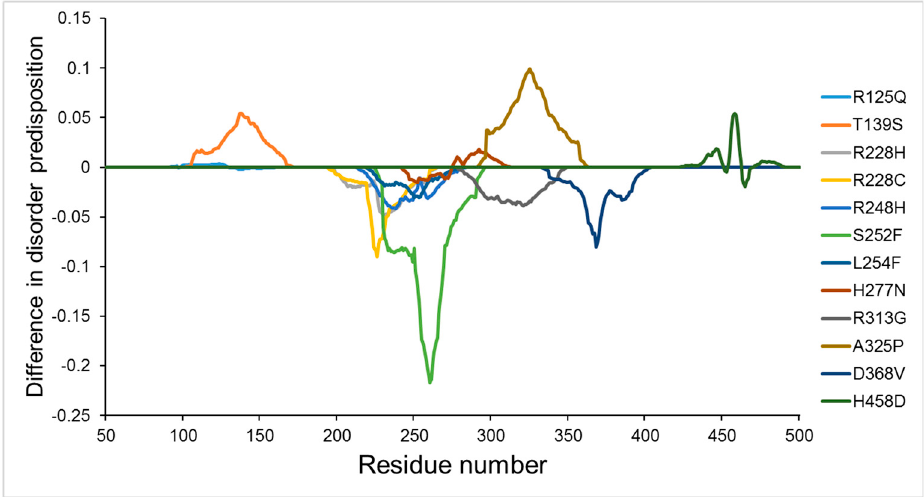
Figure 4. Effect of missense mutations on local intrinsic disorder propensity of human zinc finger protein 57 (ZFP57). The “difference disorder spectra” calculated as a simple difference between the per-residue disorder propensities of mutant and wildtype human ZFP57. The intrinsic disorder score of each residue were evaluated by the PONDR ® VSL2.